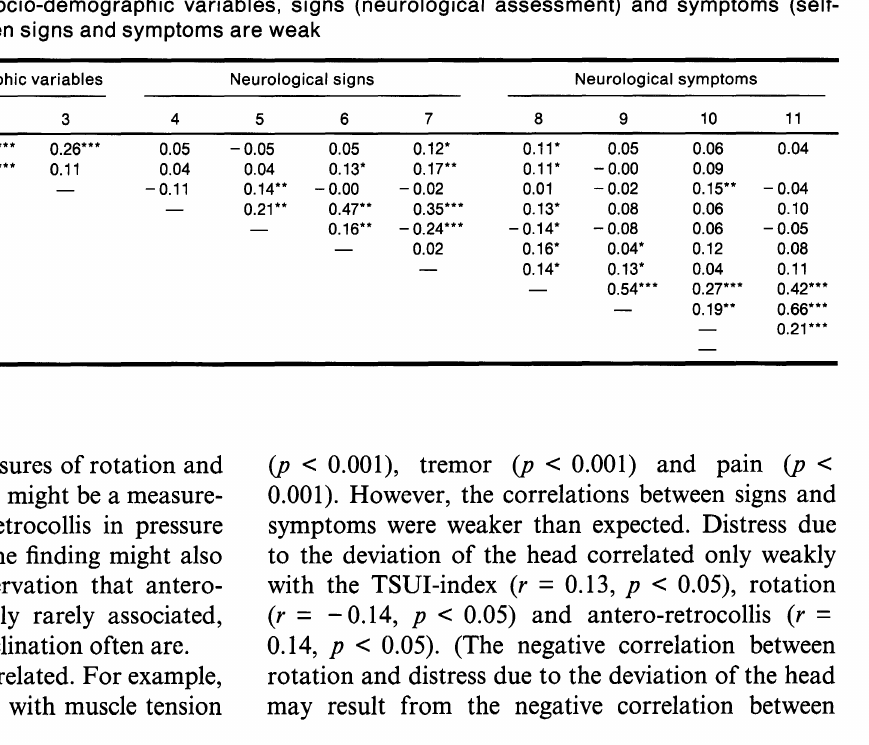
FIG. 3. Self-reported neurological symptoms, mean scores and standard deviations.